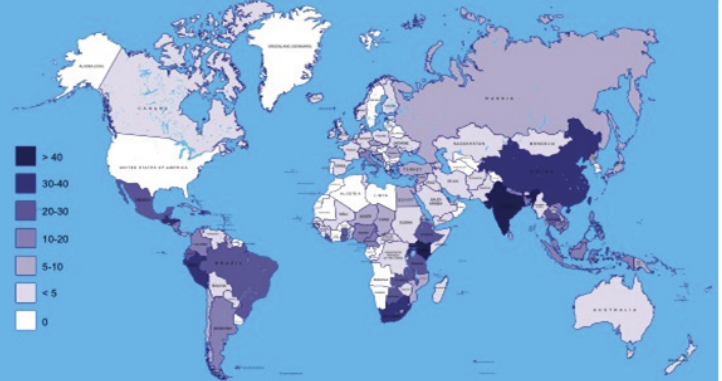
activity was assumed to be based in partner country sites. The United States was